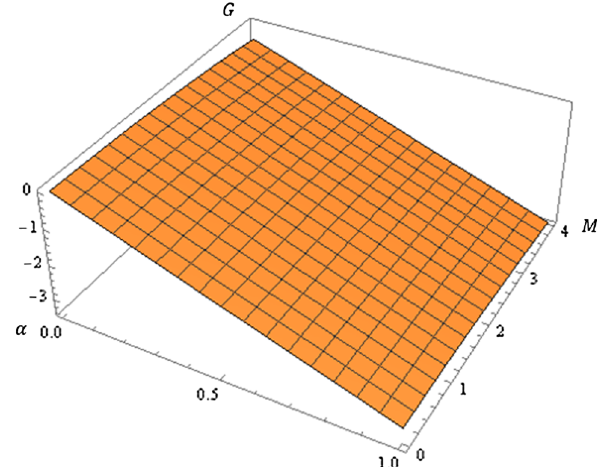
Fig. 3 A 3D plot of G ( M ,α) of a quantum corrected BTZ black hole for a fixed l = 0 . 5. We observe that, for different masses and